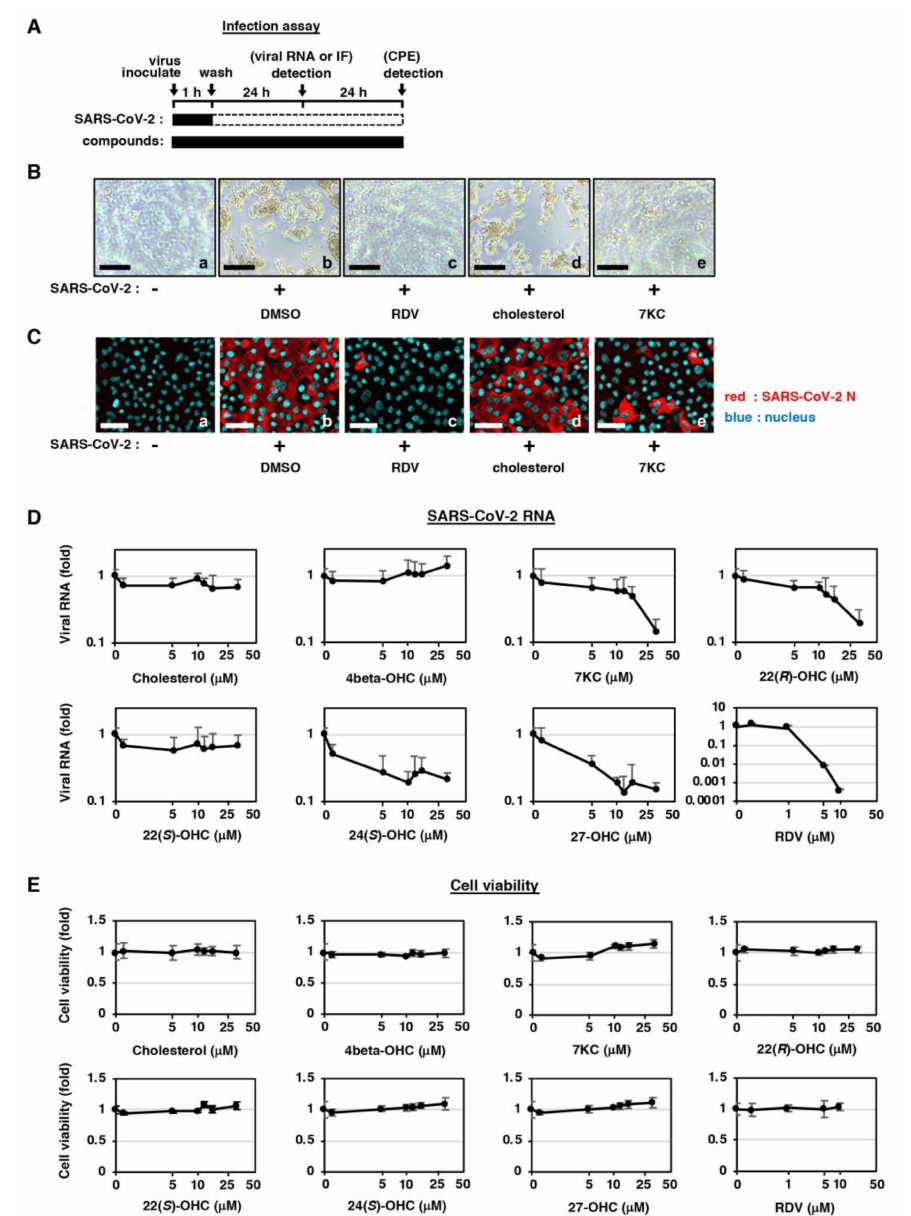
Figure 1. Oxysterols inhibit SARS-CoV-2 infection. ( A ) Schematic model of the SARS-CoV-2 infection assay. VeroE6 cells overexpressing transmembrane protease, serine 2 (TMPRSS2) were inoculated with SARS-CoV-2 in the presence of compounds for 1 h, followed by washing out the free virus and incubating the cells with the compounds for 24 or 48 h. Viral RNA in the culture supernatant and viral N protein in the cells was quantified at 24 h post-inoculation by real-time RT-PCR and immunofluorescence analyses, respectively. Cytopathic effects (CPE) were viewed under a microscope at 48 h post-inoculation. Solid and dashed boxes indicate the periods that the cells were treated with and without the compounds or the virus, respectively. ( B ) Images of the cells treated with the virus in the presence of dimethyl sulfoxide (DMSO), 10 µ M Remdesivir (RDV), 30 µ M cholesterol, or 30 µ M 7-ketocholesterol (7-KC). Scale bar, 100 µ m. ( C ) Viral N protein in the cells was detected by indirect immunofluorescence analysis. The red and blue signals represent viral N protein and nuclei, respectively. Scale bar, 50 µ m. ( D ) Dose-response curves for SARS-CoV-2 RNA upon treatment with the compounds as indicated. OHC: hydroxycholesterol. Viral RNAs in the culture supernatant were quantified by real-time RT-PCR and plotted against compound concentrations up to 30 µ M. ( E ) Viability of cells treated with compounds as indicated for 24 h was quantified using an MTT